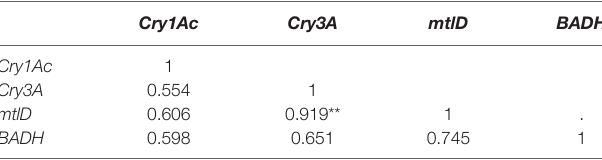
Cry3A decreased gradually over the same time period. The mean Cry1Ac content varied between 3.01 and 9.30 ng·g − 1 . The no. 9 line showed the lowest Cry1Ac content of 0.46 ng·g − 1 in June, and the no. 7 line showed the highest Cry1Ac content of 18.41 ng·g − 1 in October. The mean Cry3A content varied among strains from 4110.21 ng·g − 1 to 15283.842 ng·g − 1 . The